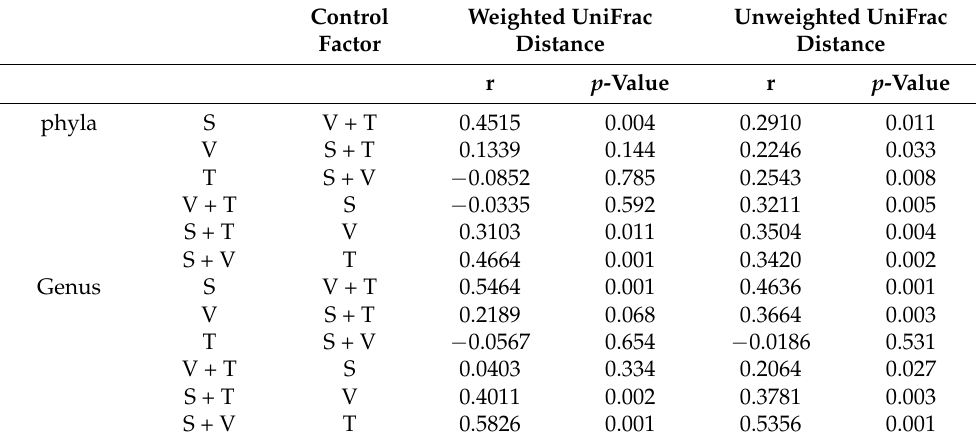
Figure 7. Redundancy analysis (RDA) of soil microbial communities and environmental factors based on phyla level ( A ) and genus level ( B ) in alpine meadow. The red arrows represent the direction and significance of environmental factors with microbial community structures. IAM, intact alpine meadow; MDAM, moderately degraded alpine meadow; BSB, black soil beach; AAG, artificial grassland; EC, electrical conductivity; TN, total nitrogen; TP, total phosphorus; TK, total potassium. Table 3. The results of correlation between soil bacterial community UniFrac distance and environmental variables using partial Mantel test analysis under phyla level and genus level.